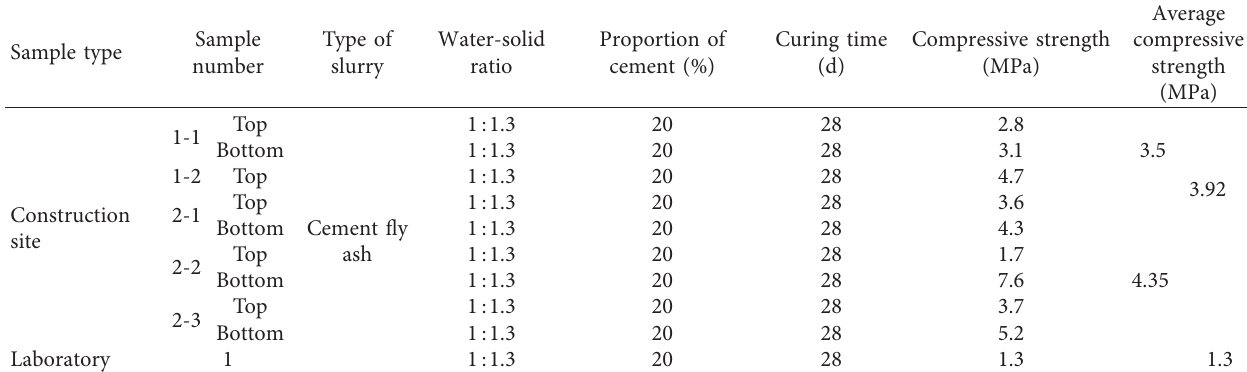
Table 2: 28-day compressive strength of consolidating objects.